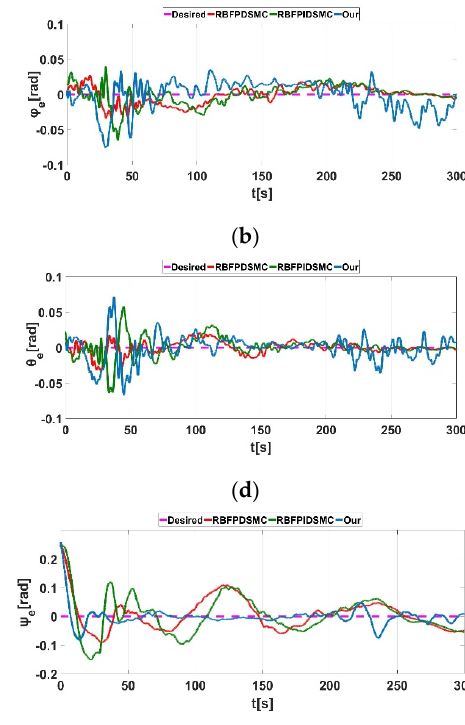
; ( c ) 𝑦 ; ( d ) 𝜃 𝑒 ; ( e ) z 𝑒 ; ( f ) 𝜓 . 𝑒 𝑒 𝑒 , 𝑒